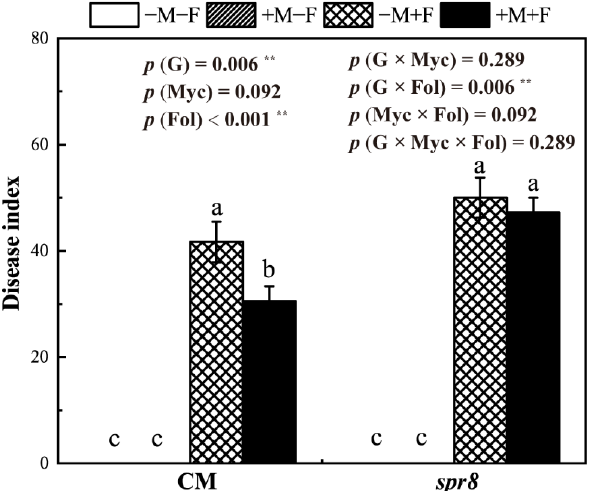
Figure 1. Effects of inoculation with Rhizophagus irregularis (Myc) and Fusarium oxysporum f. sp. Lycopersici inoculation (Fol) on the disease index of CM and spr8 plants (G). − M and +M represent non-inoculation and inoculation with Rhizophagus irregularis , respectively. − F and +F represent non-inoculation and inoculation with Fusarium oxysporum f. sp. Lycopersici , respectively. Same lowercase letters above the columns indicate non-significant difference ( p < 0.05) between corresponding treatments. **— p < 0.01.